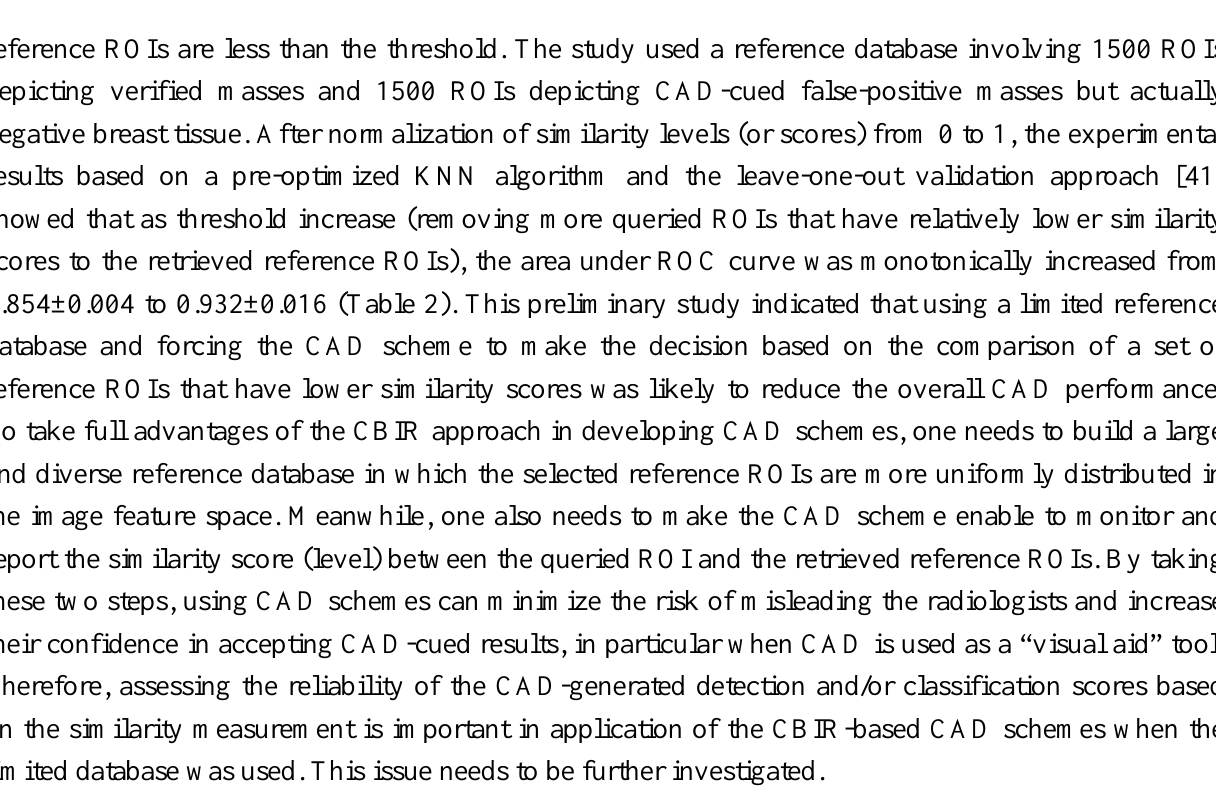
Table 2: The change of CAD performance as the increase of threshold values on the queried